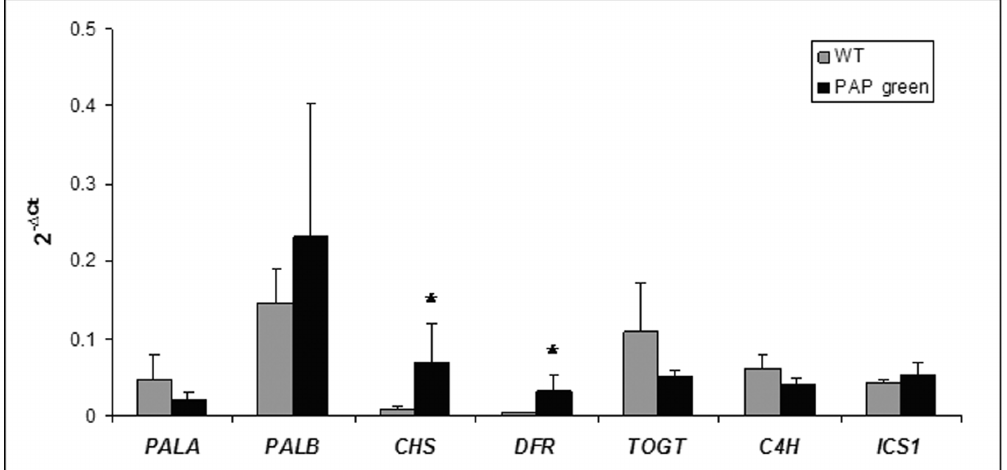
Figure 1. Molecular characterization of WT and PAP transgenic plants. The expression level (2 2 D Ct means) of genes in the phenylpropanoids pathway in WT (gray bars) and PAP green (black bars) plants. Asterisks indicate significant differences at P # 0.05. Error bars represent standard error of the means.